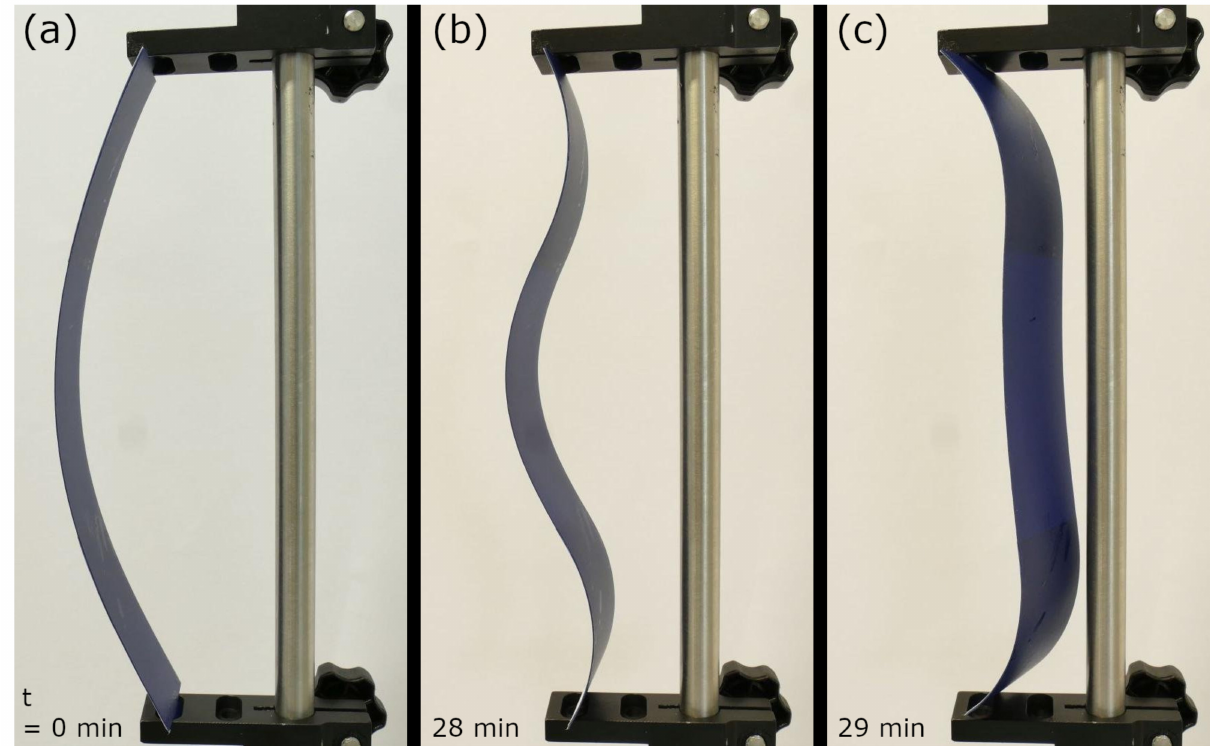
Figure 16. Self-actuated paper-polymer-based compliant system inspired by the Venus flytrap ( D. muscipula ) performing a rapid snap-through transition (at t = 29 min). ( a ) Initial state. ( b ) Half-completed movement, shortly before snap-buckling. ( c ) Final state. Times are indicated bottom